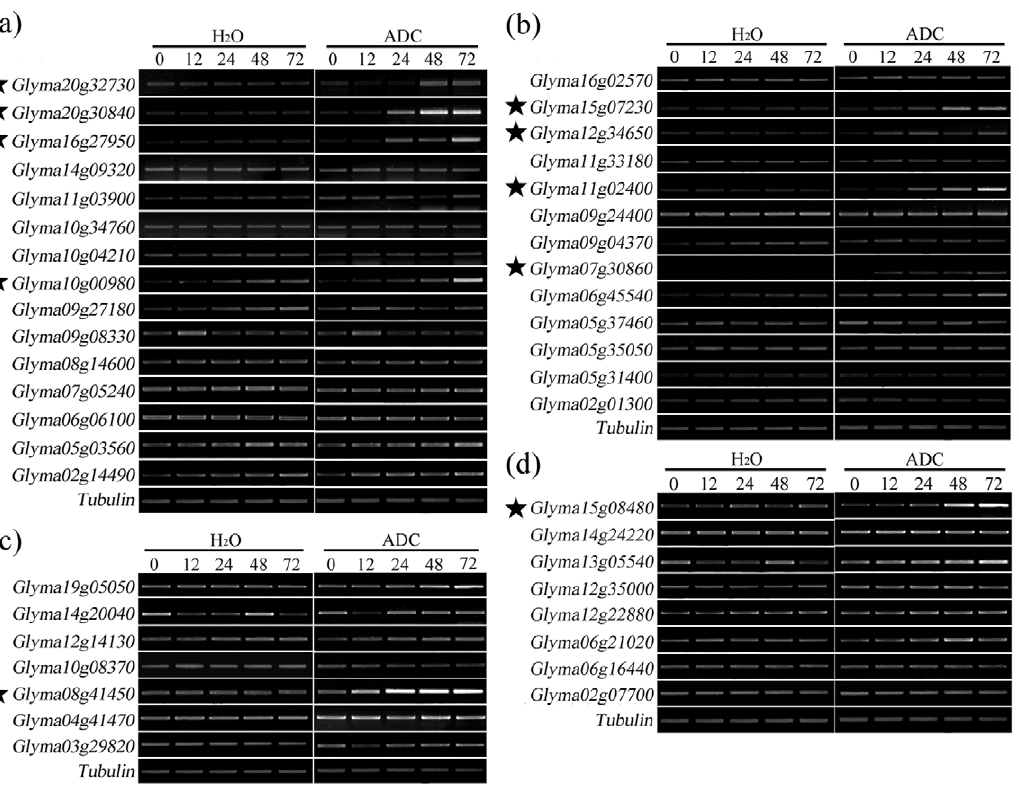
Figure 2. Expression of 45 salinity inducible TFs in seedlings exposed to 5-ADC treatment. (a) GmAP2-DREBs , (b) GmMYBs , (c). GmNACs . and (d) Gmb-ZIPs . M0-M72 refers to seedlings treated with water only for, respectively 0h, 12h, 24h, 48h and 72h, while A0-A72 refer to seedlings exposed to 50 m M 5-ADC for 0h, 12h, 24h, 48h and 72h, respectively. Each gene-specific region was amplified by RT–PCR using the gene-specific primers (Table S2). The TUBULIN gene (Genbank accession AY907703) was used as an internal control. The experiment was repeated three times with similar result.